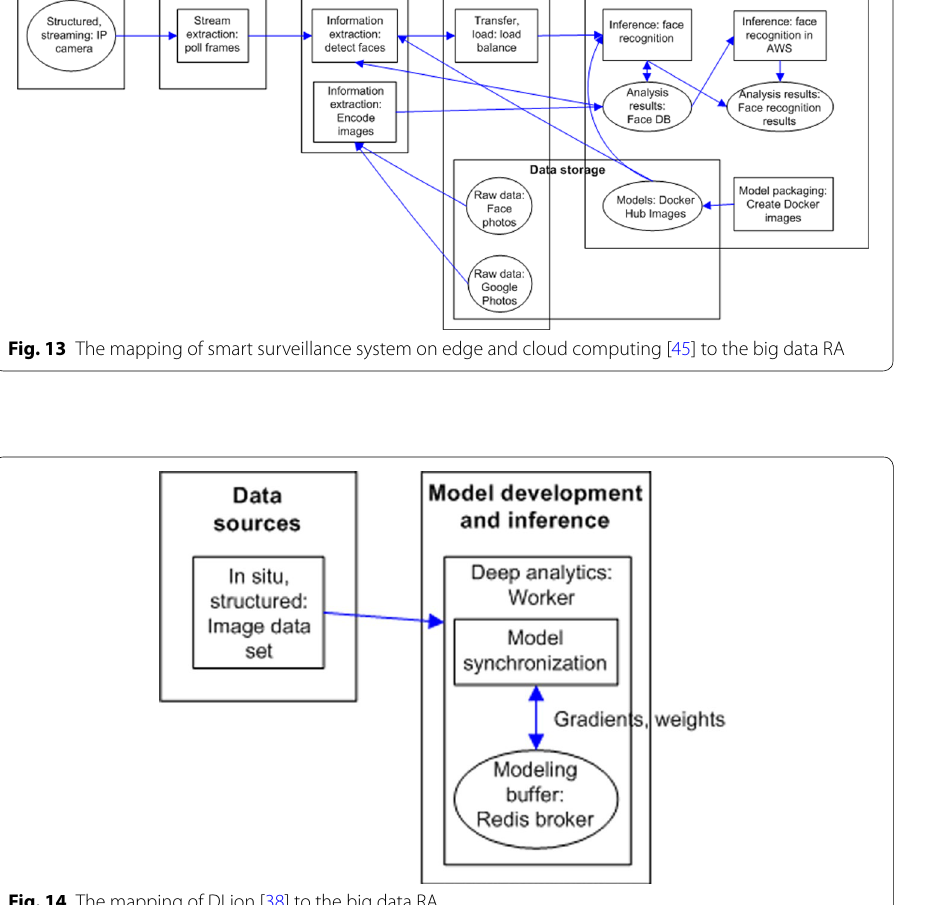
Fig. 14 The mapping of DLion [38] to the big data